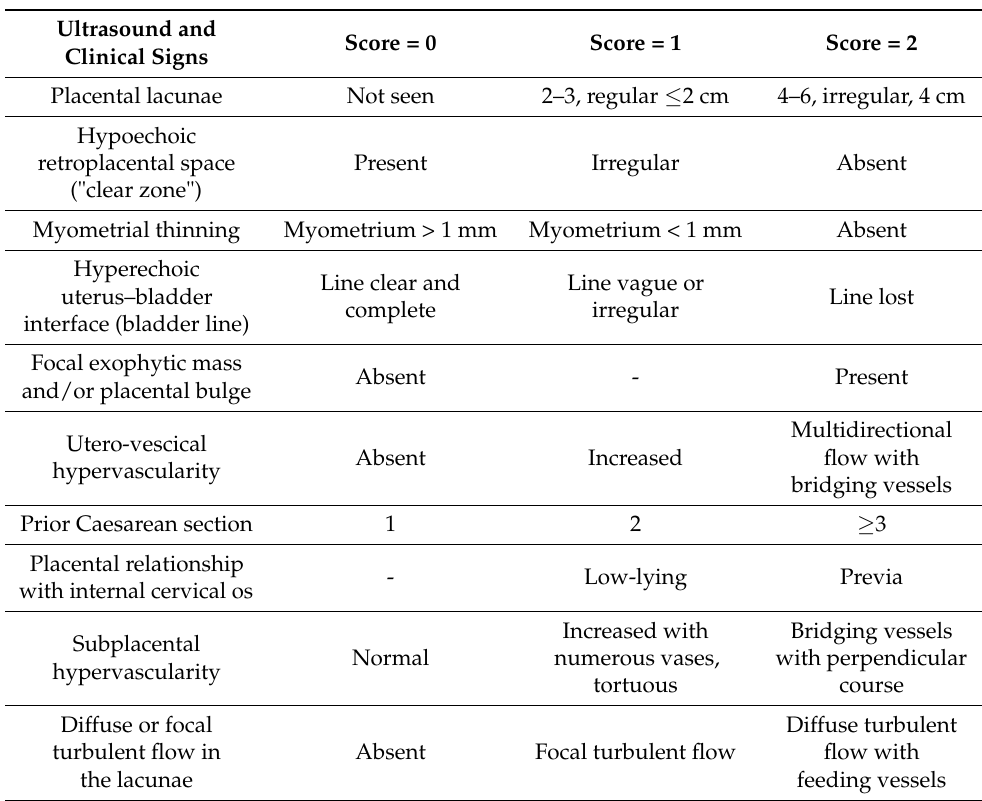
Table 1. Ultrasonographic